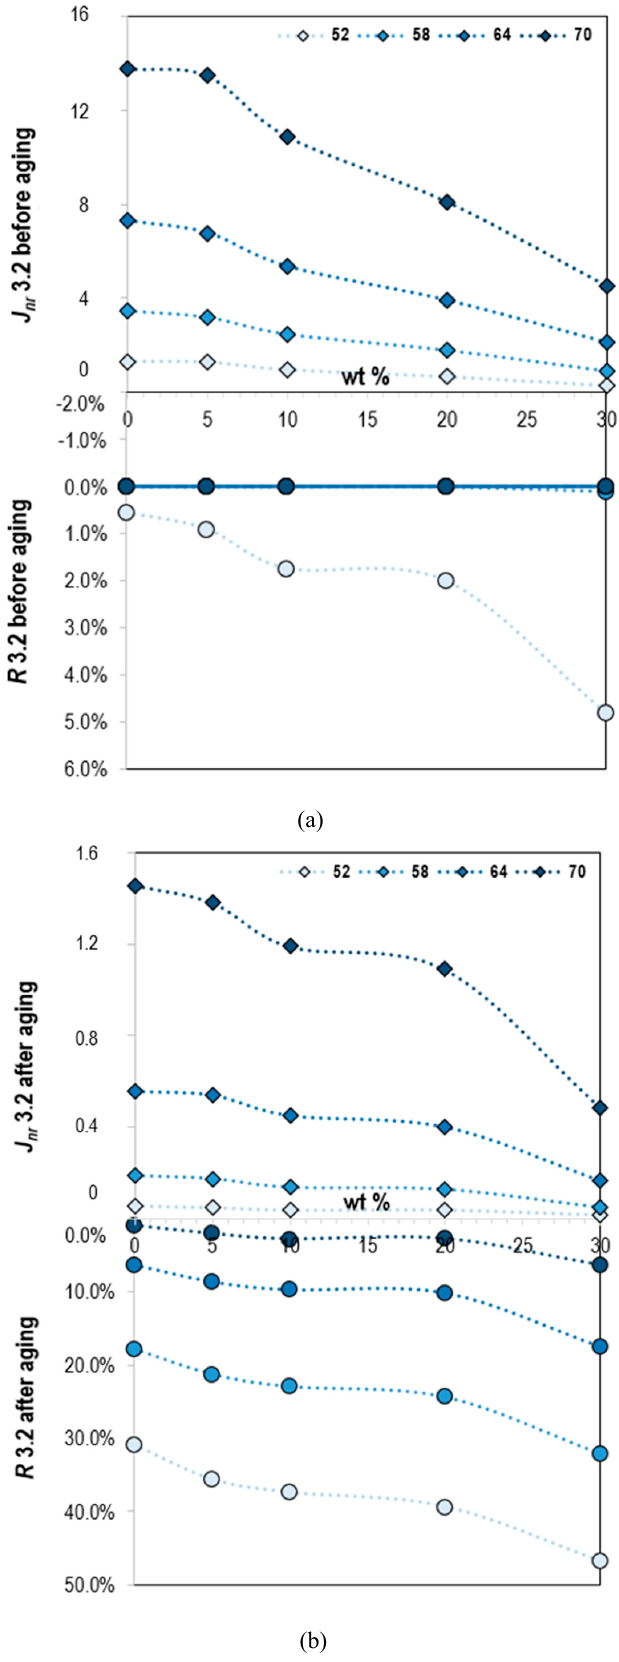
Figure 6. Nonrecoverable compliance ( J nr ) and recovery percentage ( R ) of lignin–bitumen systems ( a ) before and ( b ) after aging (stress level 3.2 kPa).